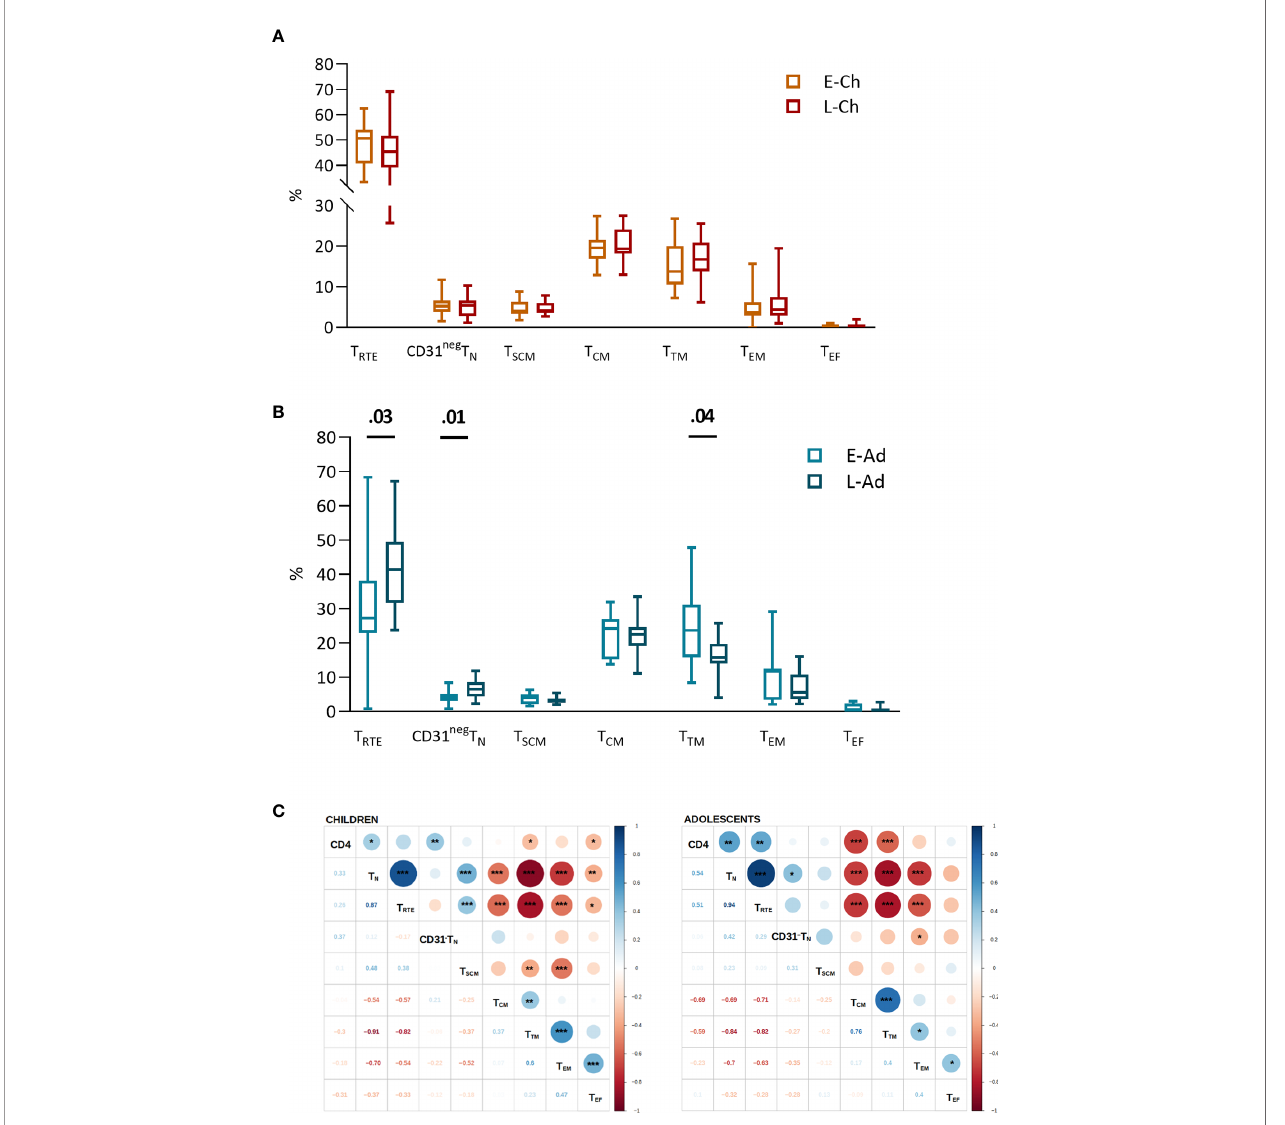
FIGURE 1 | CD4 T-cell subsets in patients treated early and late. T-cell phenotypes were assessed by fl ow cytometry on fresh whole blood ( Supplementary Material ). The percentage of each subset among total CD4 T lymphocytes is presented for children (A) and adolescents (B) , on box and whiskers plots showing the minimum and maximum values. The early and late treatment groups were compared in Mann-Whitney tests; when signi fi cant, P values are shown on the graph. Subsets are presented from the least to the most differentiated, and were de fi ned as naive T N (CD45RA + CCR7 + ); recent thymic emigrants, T RTE (CD45RA + CCR7 + CD31 + ); CD31 neg T N (CD45RA + CCR7 + CD31 - ); central memory, T CM (CD45RA - CCR7 + ); transitional memory T TM (CD45RA - CCR7 - CD27 + ); effector memory T EM (CD45RA - CCR7 - CD27 - ) and effector T EF (CD45RA + CCR7 - CD27 - CD28-) cells. (C) The correlograms present Spearman ’ s rank correlation coef fi cients as symbols (upper quadrants) and values. Signi fi cant associations are indicated by symbols (* p < .05; ** p < .01; *** p < .001). CD4 T-cell counts were used for correlation